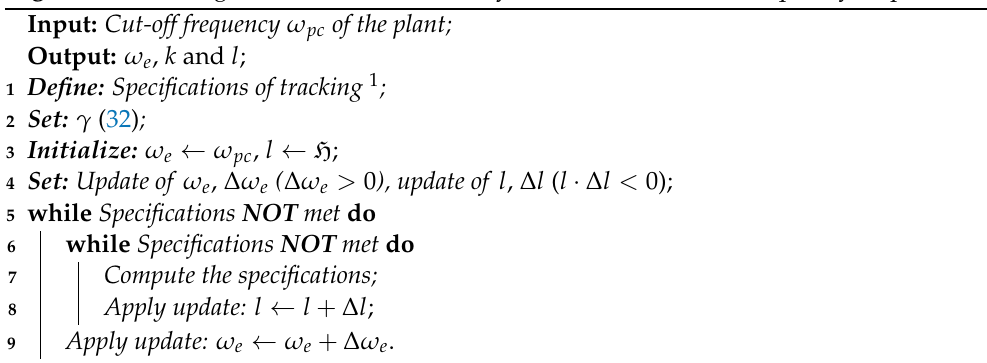
Algorithm 1: An algorithm to tune desired dynamic-based GIS via frequency